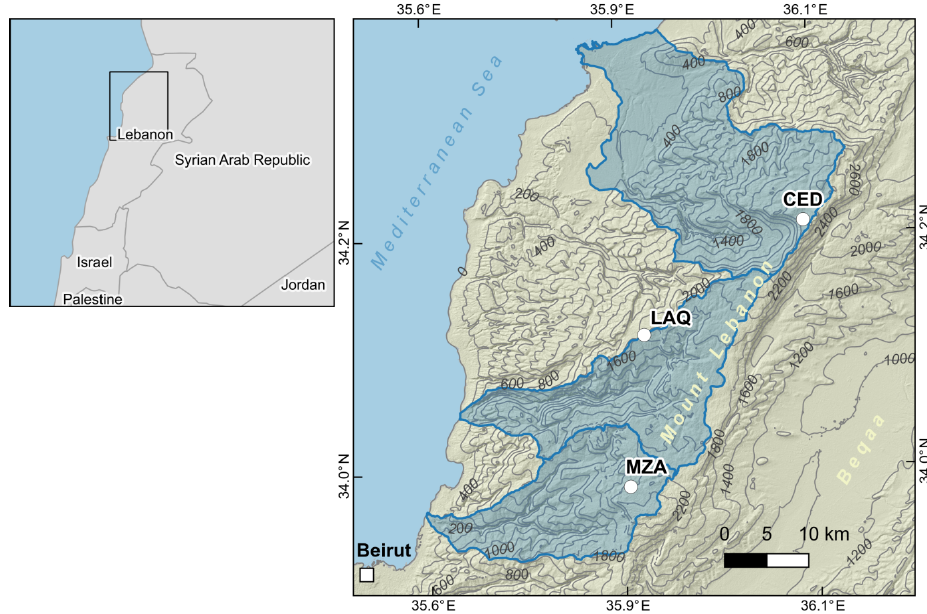
Figure 1. Study area. The three studied basins are marked in blue (from north to south: Abou Ali, Ibrahim, and El Kelb). Elevation contours are given in meters above the WGS-84 ellipsoid. Table 1. Main characteristics of the river basins in this study (defined using the surface topography). Annual flow based on unpublished data from the Litani river authority gauging stations (1992–2016).